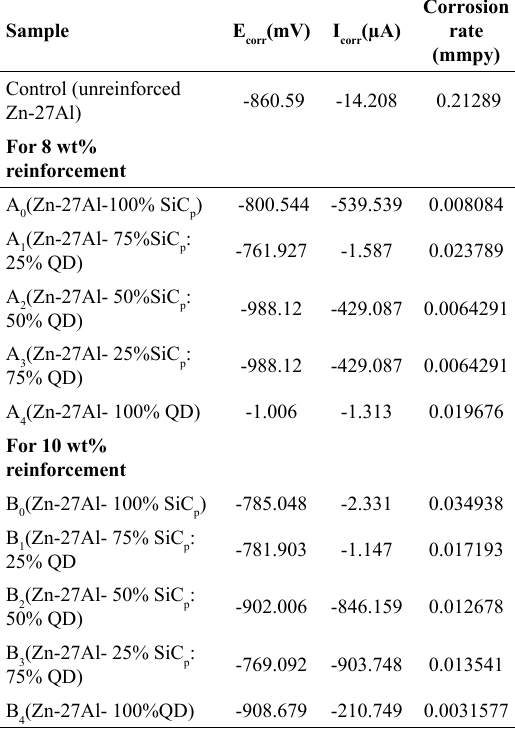
Table 2. Electrochemical data of the unreinforced and reinforced ZA-27 alloy composites from the tafel extrapolations in 3.5wt% NaCl